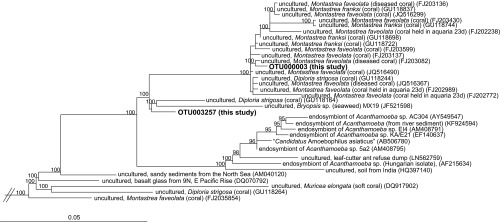
Phylogenetic relationships between representatives of the Bacteroidetes “Candidatus Amoebophilus” (based on 1,218 bp) and amplicon SSU rRNA gene sequences obtained from coral colonies examined in this study (shown in bold type). The bar shows 0.05 substitutions per nucleotide position. Bootstrap values greater than 70% are listed. Outgroup sequences included Leptospira interrogana (DDBJ accession no. Z12817), Staphylococcus aureus subsp. anaerobius (DDBJ accession no. D83355), and Chloroflexus aurantiacus (DDBJ accession no. CP000909).